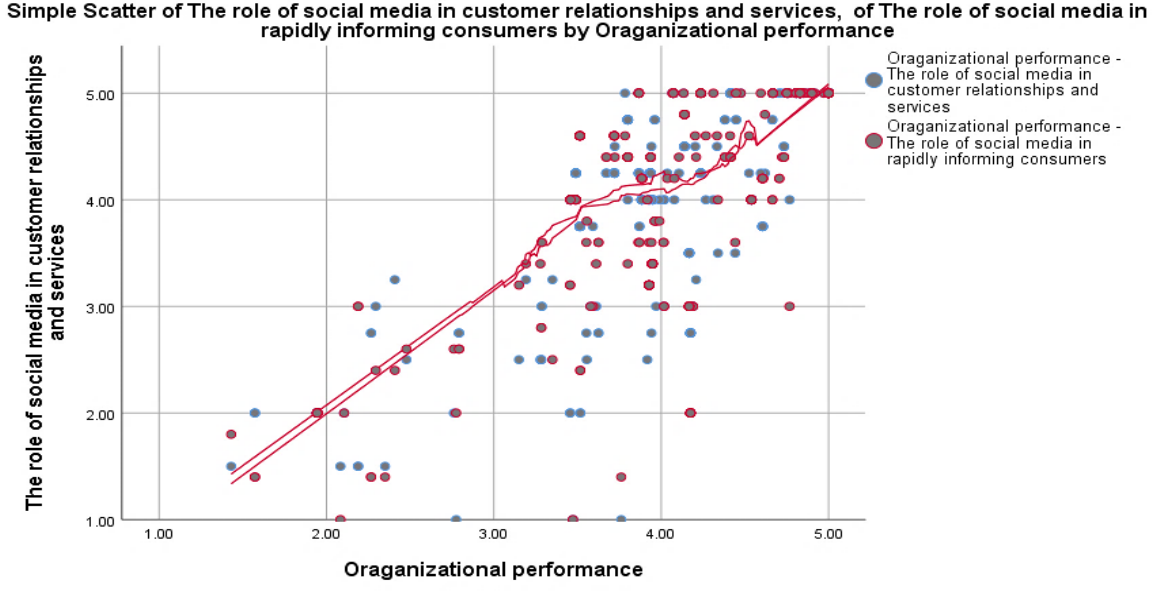
Figure 3. Simple scatter of role of social media in customer relationships and services.